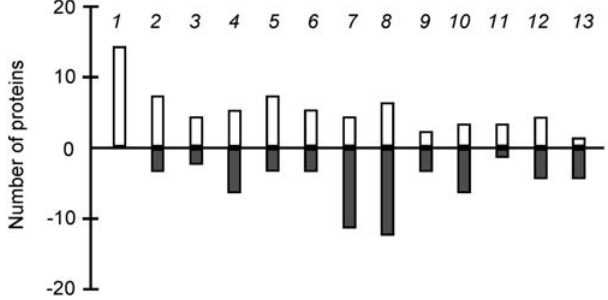
Figure 4. Functional profiling of up- and downregulated proteins in the IrrE-expressing E. coli strain compared with the control strain. The functional role category annotation is that provided by BioCyc (http://biocyc.org/). Each column represents the number of proteins with at least twofold changes in a selected functional category. Positive and negative values indicate up- and down-regulation, respectively. Columns: 1, nucleotide biosynthesis; 2, amino acid biosynthesis; 3, biosynthesis of cofactors, small molecule carriers; 4, RNA synthesis, modification, DNA transcription; 5, proteins (translation and modification); 6, proteins (chaperones); 7, energy metabolism; 8, carbon utilization; 9, central intermediary metabolism; 10, transport and binding proteins; 11, cytoskeleton; 12, cellular processes and 13, hypothetical proteins.